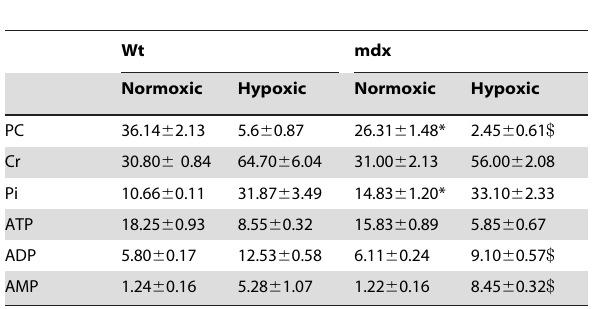
Table 1. Data obtained by HPLC analysis of control and mdx mouse